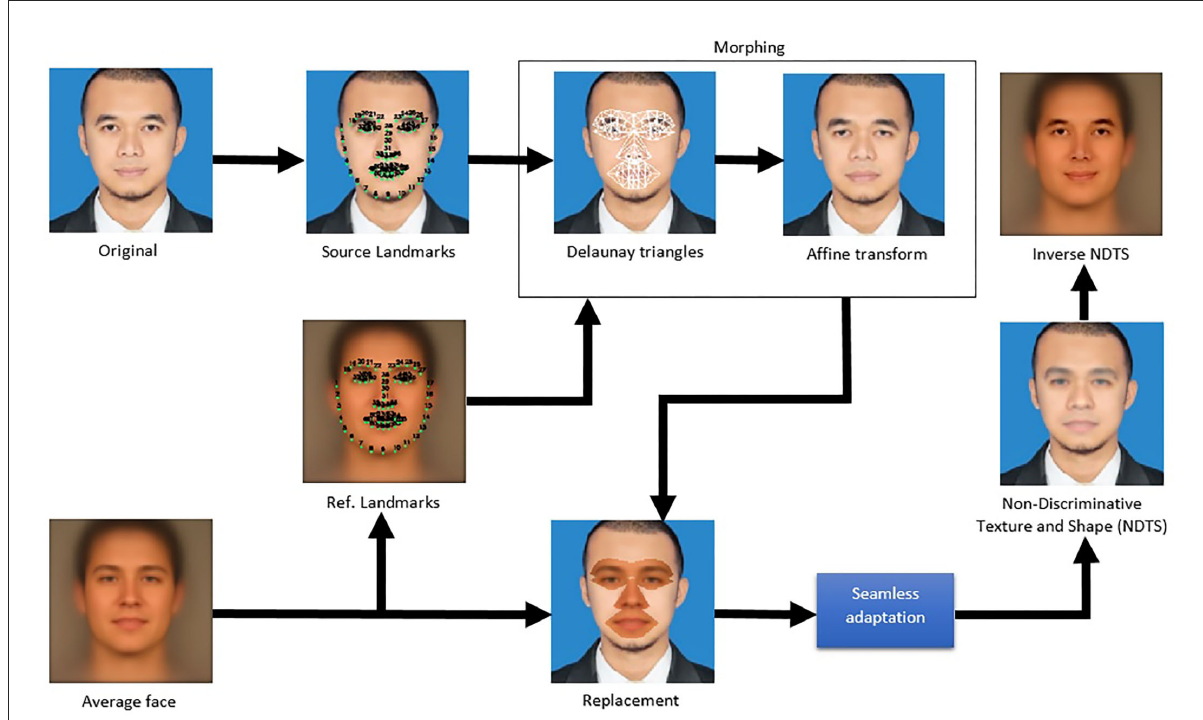
showed the behavior comparison